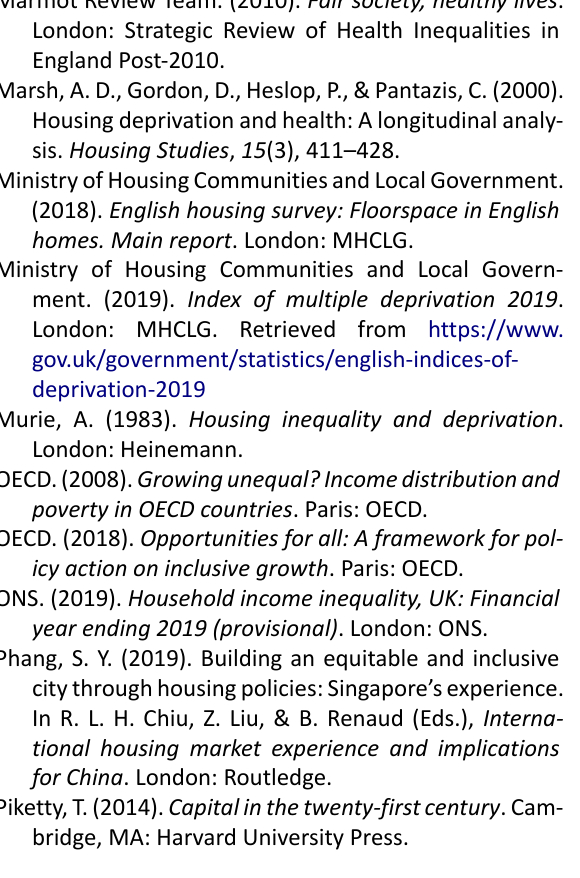
table growth: lessons from the BRICS (Working